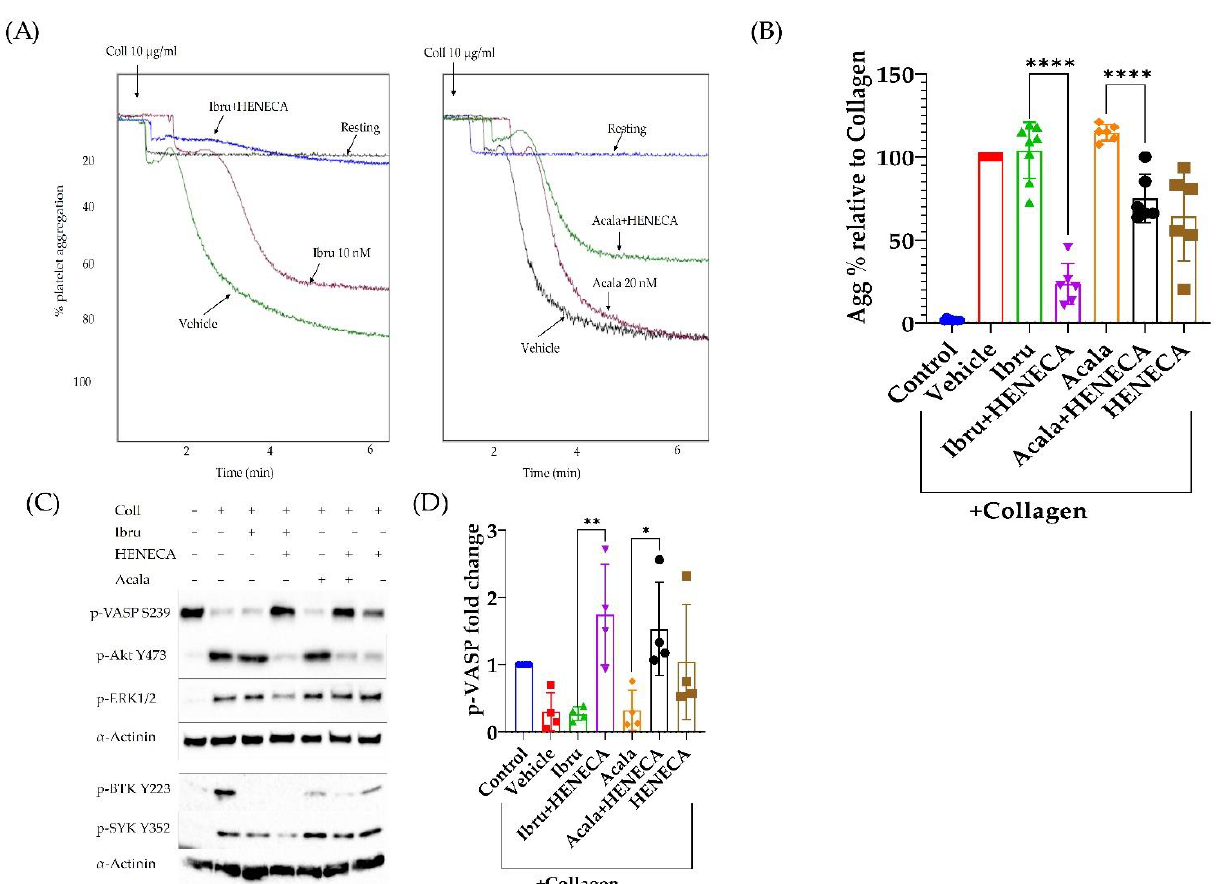
Figure 5. Adenosine 2A receptor activation amplifies the antiplatelet effects of ibrutinib by in- hibiting collagen-mediated changes in VASP phosphorylation. ( A ) Representative aggregation traces showing the effect of ibrutinib (10 nM) and acalabrutinib (20 nM) ± HENECA (stable adeno- sine derivative, 10 uM) on collagen (10 ug/mL)-induced platelet aggregation. Washed platelets were pre-incubated with the inhibitors for 55 min and with HENECA for 5 min at 37 °C before addition of collagen. ( B ) Combined results of the effect of ibrutinib and acalabrutinib ± HENECA on collagen-induced platelet aggregation (n ≥ − 5). ( C ) The effect of ibrutinib and acalabrutinib ± HENECA on collagen-induced changes in BTK, SYK, VASP, Akt and ERK phosphorylation. ( D ) Combined results of the effect of ibrutinib and acalabrutinib ± HENECA on VASP phosphoryla- tion. Data are presented as fold change compared to control (n = 4). * p < 0 .05, ** p < 0.01, **** p < 0.0001